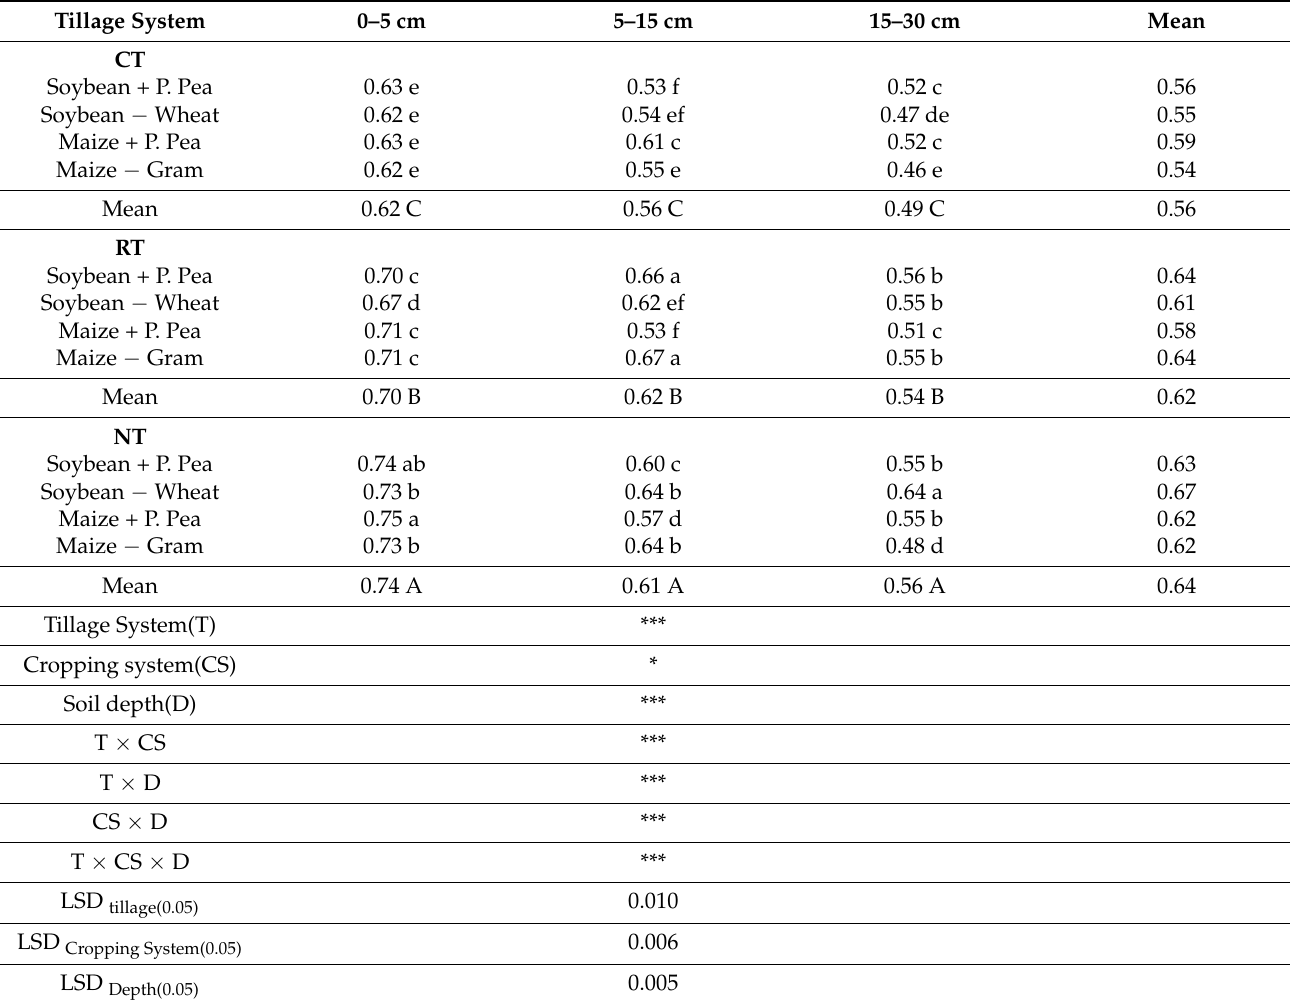
Table 3. Effect of different tillage and cropping system on soil organic carbon (SOC) (%) at different soil